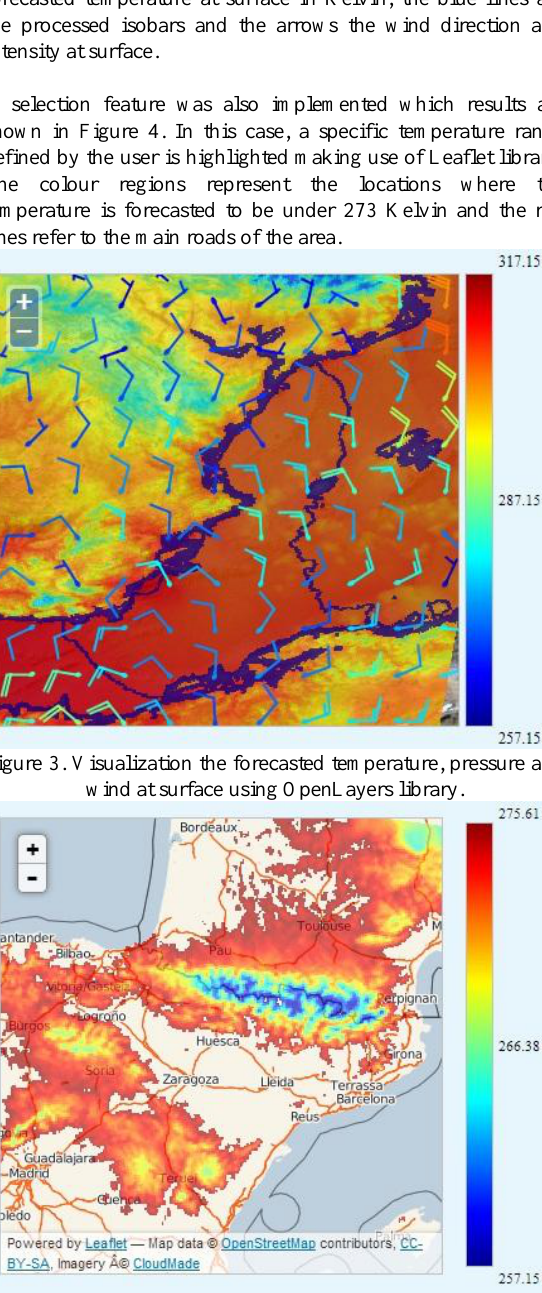
Figure 4. Visualization of the required temperature range using Leaflet